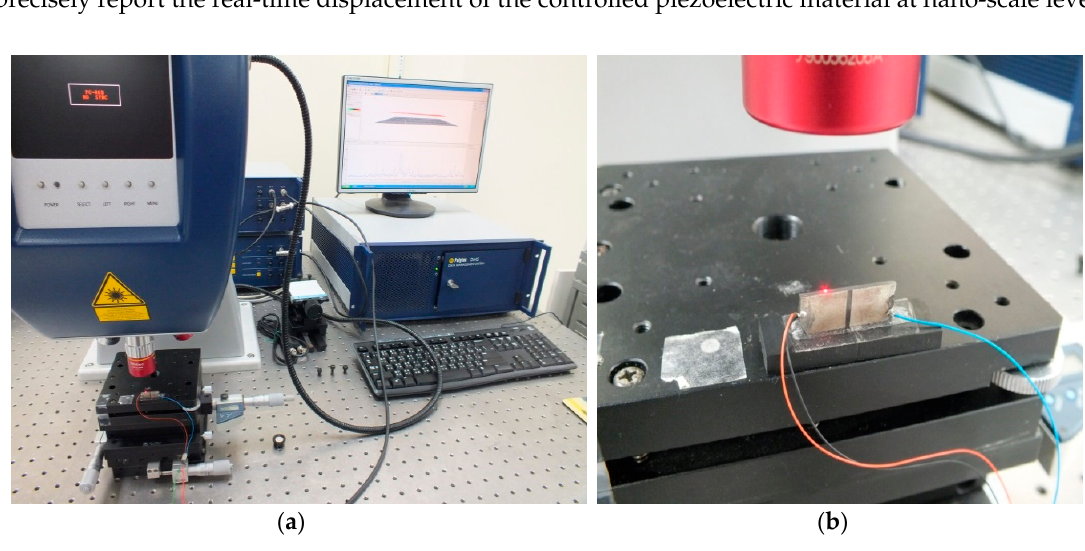
Figure 3. ( a ) A displacement measurement apparatus (MSN-400, Polytec, Berlin, Germany) and a control device is built up for the verification of the positioning performance of this proposed method, and ( b ) the enlarged picture of the controlled piezoelectric material in ( a ).